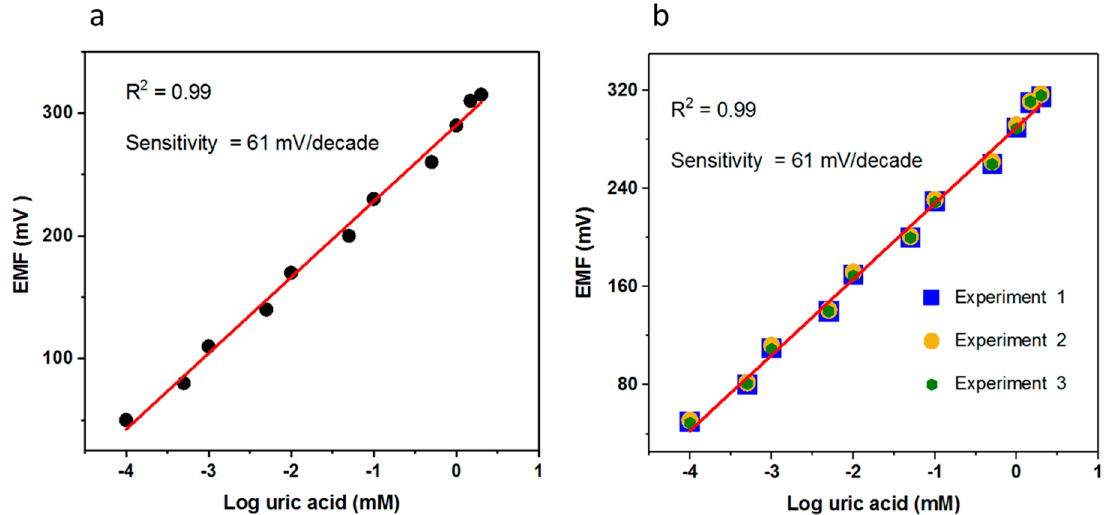
Figure 4. ( a ) The calibration fitting of the potentiometric uric acid biosensor for a concentration range of 0.0001–10 mM uric acid concentration; ( b ) the repeatability response of the uric acid biosensor in the concentration range of 0.0001–10 mM uric acid.